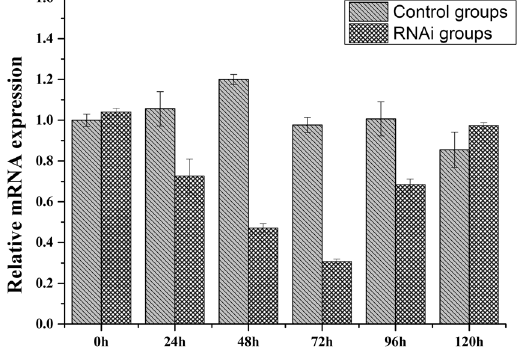
Figure 5. Relative mRNA expression of CgCSAD1 after dsRNA injection. The 0 h of control group are the reference samples. The y-axis represent the fold changes between the expressions of treated samples and reference samples. Vertical bars represent the mean ± SD (N =